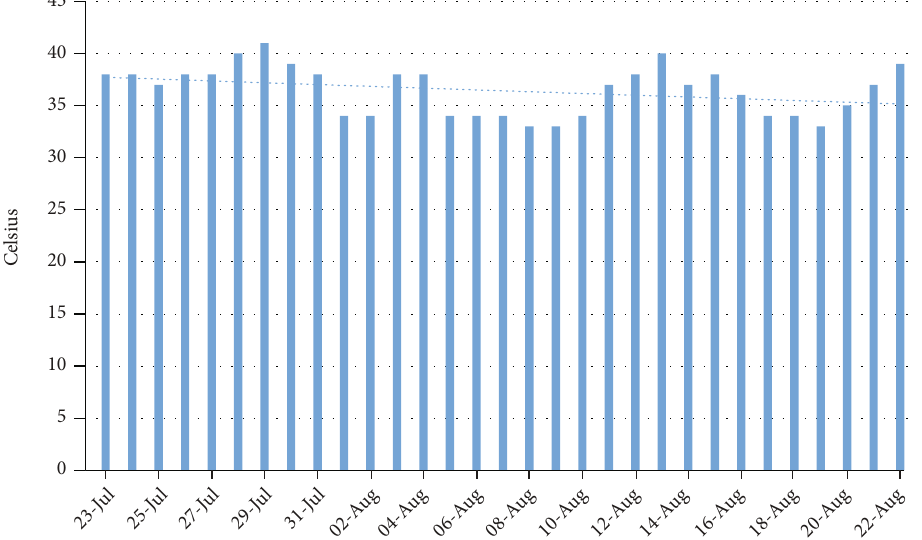
Figure 8: Temperature in Tehran from July 23 to August